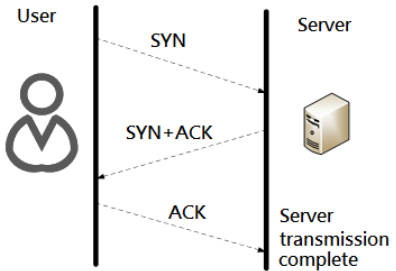
Figure 5. TCP normal three-way handshake process.